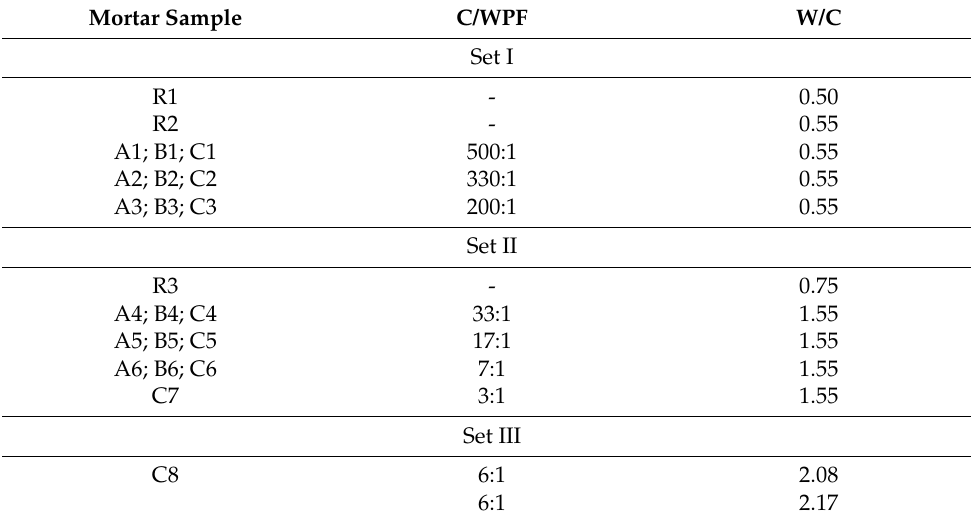
Table 6. Formulations for fiber-cement